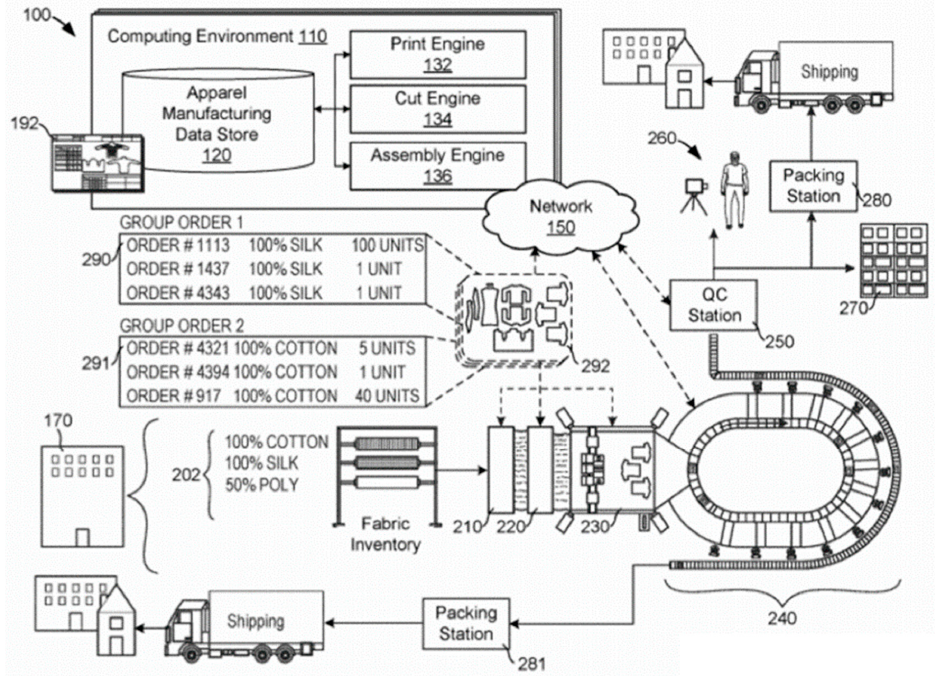
Figure 3. An automated apparel production and distribution system.